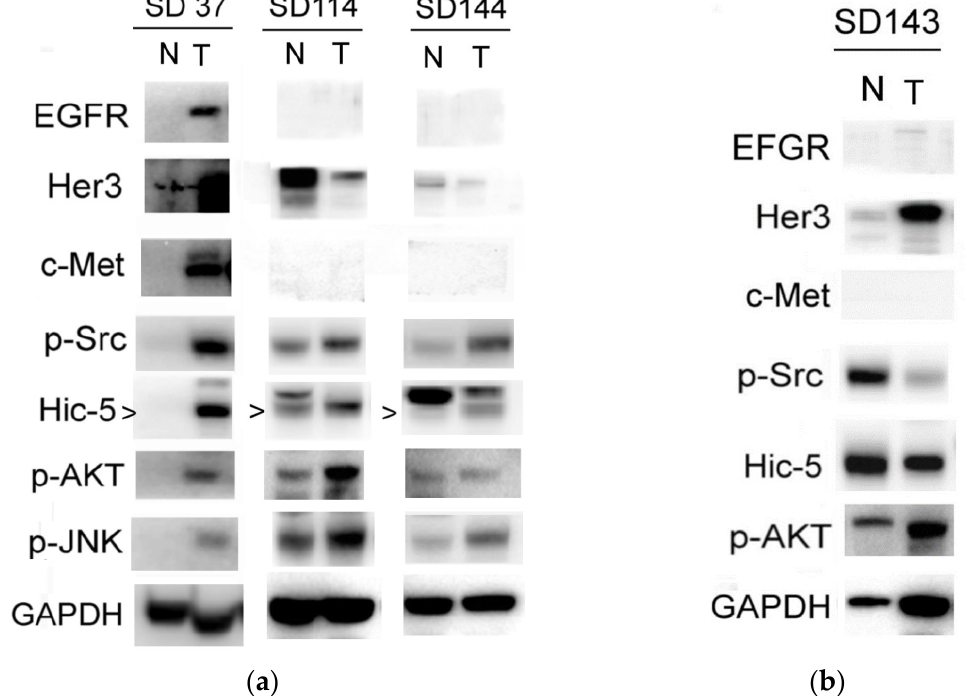
Figure 1. Signal molecules deregulated in CCA tissues. Western blots of indicated molecules in tumor (T) and normal counterpart (N) from different CCA tissues of patient SD37, SD114, SD 144 ( a ),